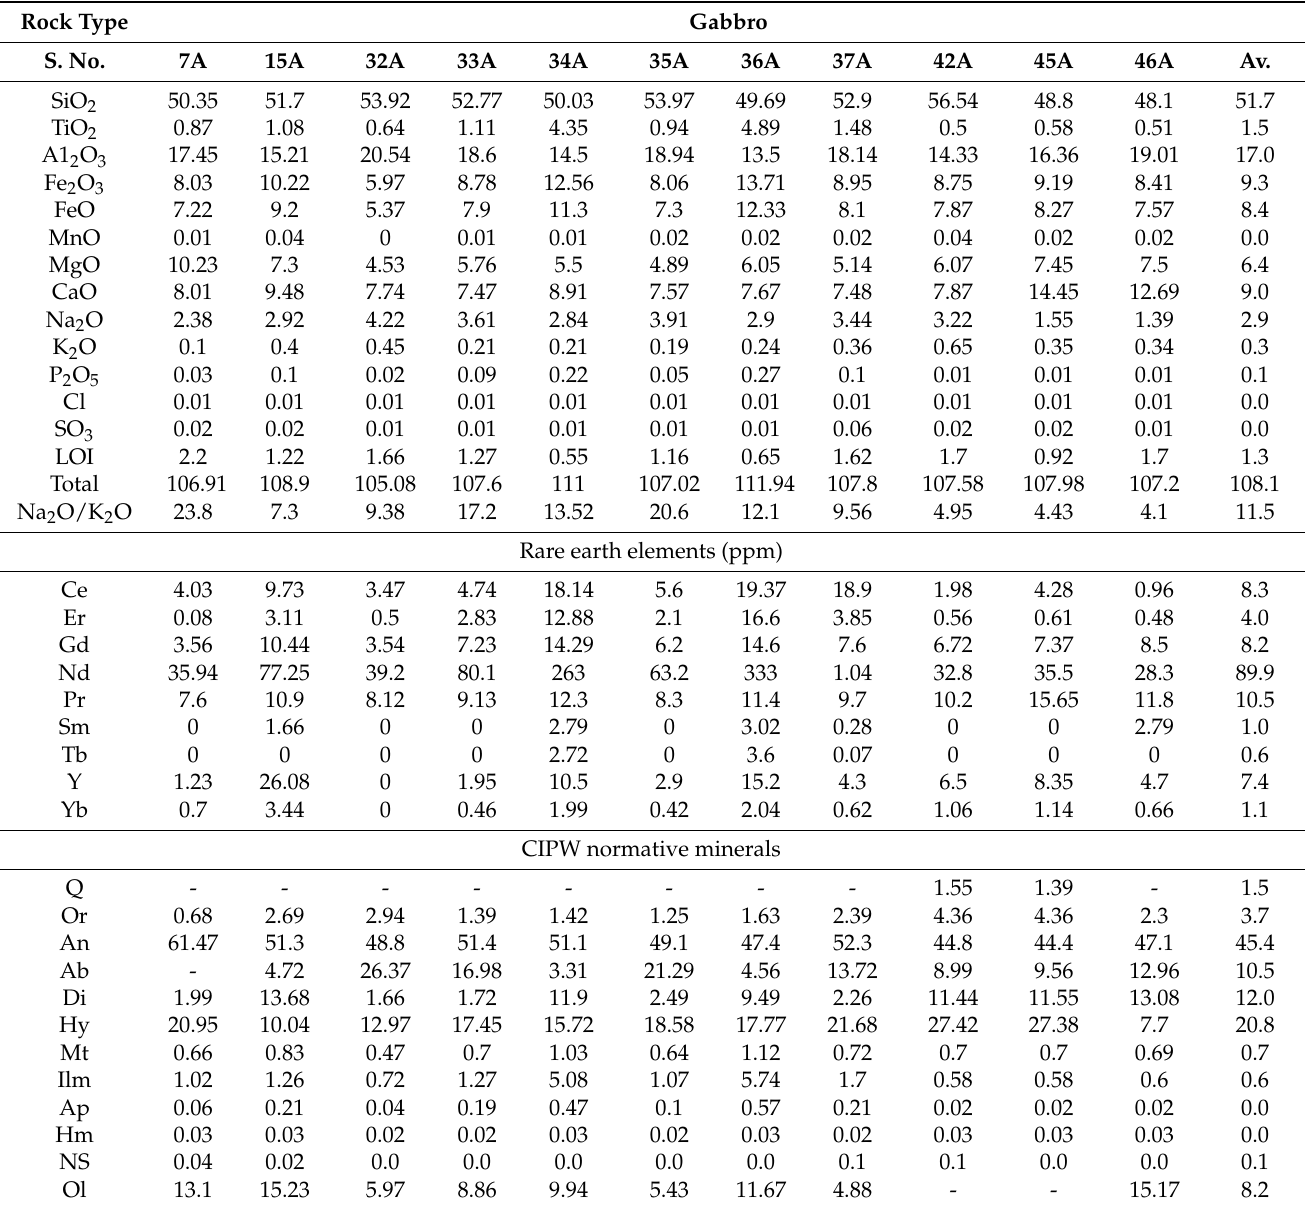
Table 7. Major oxides (wt.%), trace elements (ppm), some elemental ratios, and CIPW norm of the gabbroic